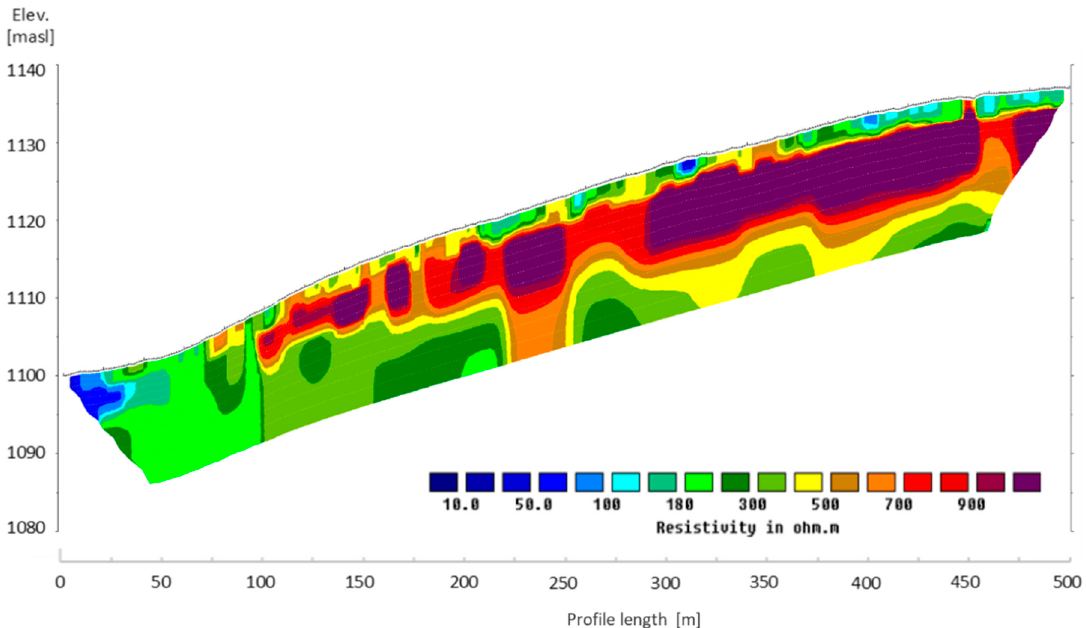
Figure 3. Resistivity tomography with topography at a transect stretching from the wetland to the hilltop (500 m profile length), unit electrode spacing 2.5 m.